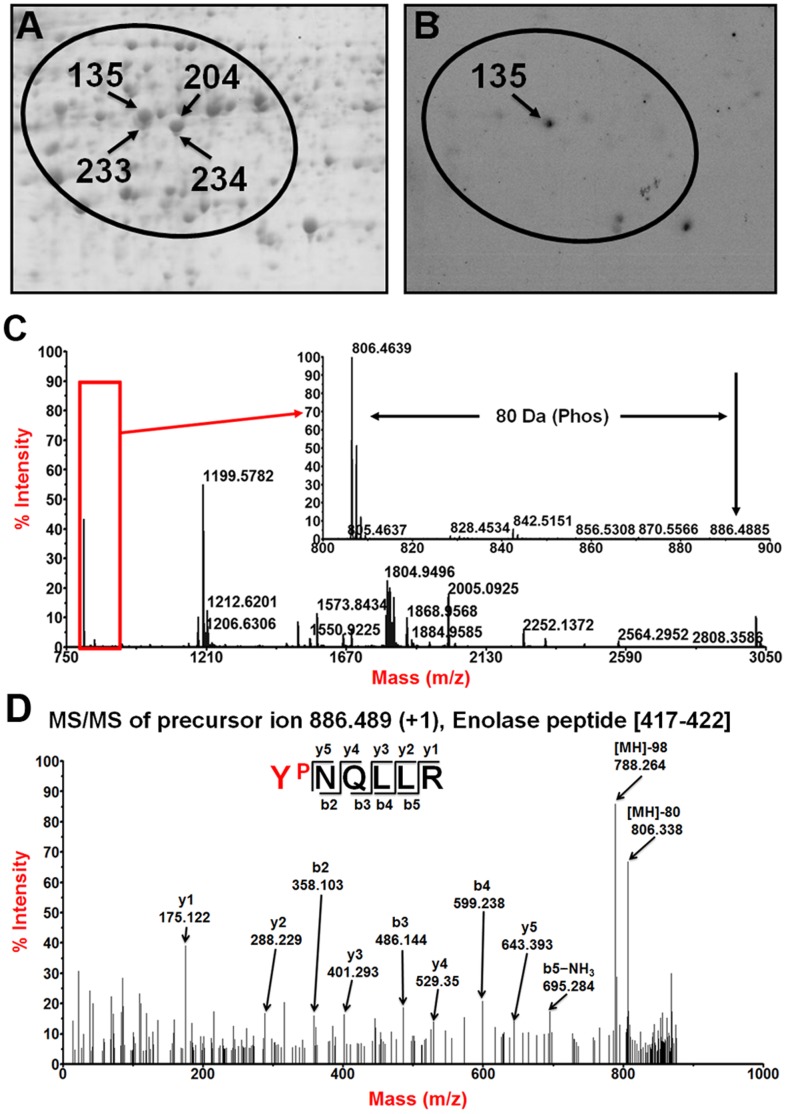
Isoforms of cotton fiber enolase protein are phosphorylated at different levels.A) A 2-DE map of total proteins in 10 DPA cotton fibers. The four isoforms of cotton fiber enolase protein are shown in the 7 cm×5 cm gel slice of the 24 cm×20 cm raw 2-D gel. B) Western blot analysis of cotton fiber protein phosphorylation after 2-DE separation. One isoform of cotton fiber enolase protein (spot 135) recognized by the antibody is shown. C) PMF mass spectra of trypsin digest of the spot 135 isoform of enolase protein displaying the non-phosphopeptide (Mw 806.4639) and the predicted phosphopeptide (Mw 886.4885). D) MS/MS spectra of the spot 135 isoform of the enolase protein phosphopeptide YPNQLLR identified by MALDI TOF/TOF and MASCOT scoring.